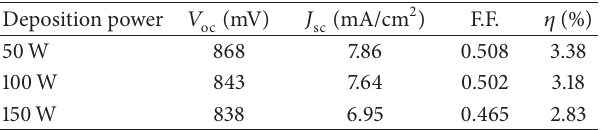
Figure 9: Current-voltage characteristics of the p-i-n 𝛼 -Si:H thin- film solar cells under illumination. ) , short-circuit current Table 1: Values of open-circuit voltage (𝑉 oc ) , fill factor (F.F.), and efficiency ( 𝜂 ) for solar cells with density (𝐽 sc the different power-deposited GZO thin